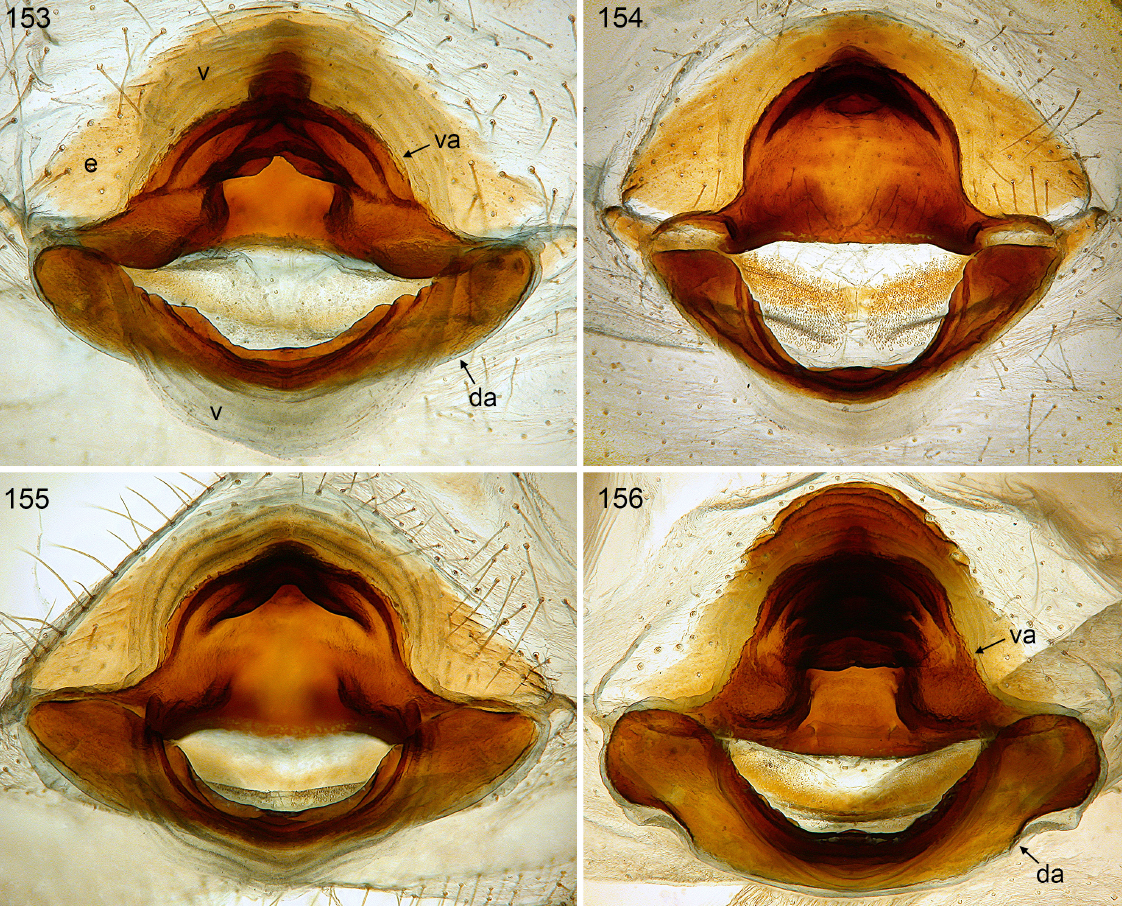
Figs 153–156. Stygopholcus Kratochvíl, 1932; cleared female genitalia in dorsal views; dorsal sclerotized arcs tilted towards the back. 153 . S. absoloni (Kulczyński, 1914); from Balićeva špilja, Croatia (ZFMK (Ar 22195)). 154 . S. skotophilus Kratochvíl, 1940; from Pećina u Ivici, Montenegro (ZFMK (Ar 22196)). 155 . S. montenegrinus Kratochvíl, 1940; from Studenačka pećina, Montenegro (ZFMK (Ar 22201)). 156 . S. photophilus Senglet, 1971; from Choumerion/Pérama, Crete (MHNG). Abbreviations: da = dorsal arc; e = epigynal plate; v = ʻvalve’; va = ventral